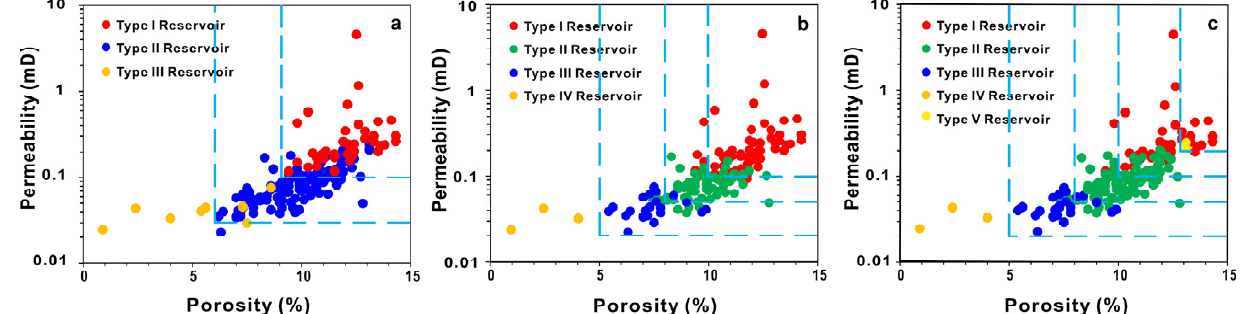
Figure 7. Relationships between the porosity and permeability of different types of reservoirs are obtained by different cluster numbers. ( a ) The number of clusters is 3, ( b ) The number of clusters is 4, ( c ) The number of clusters is 5.